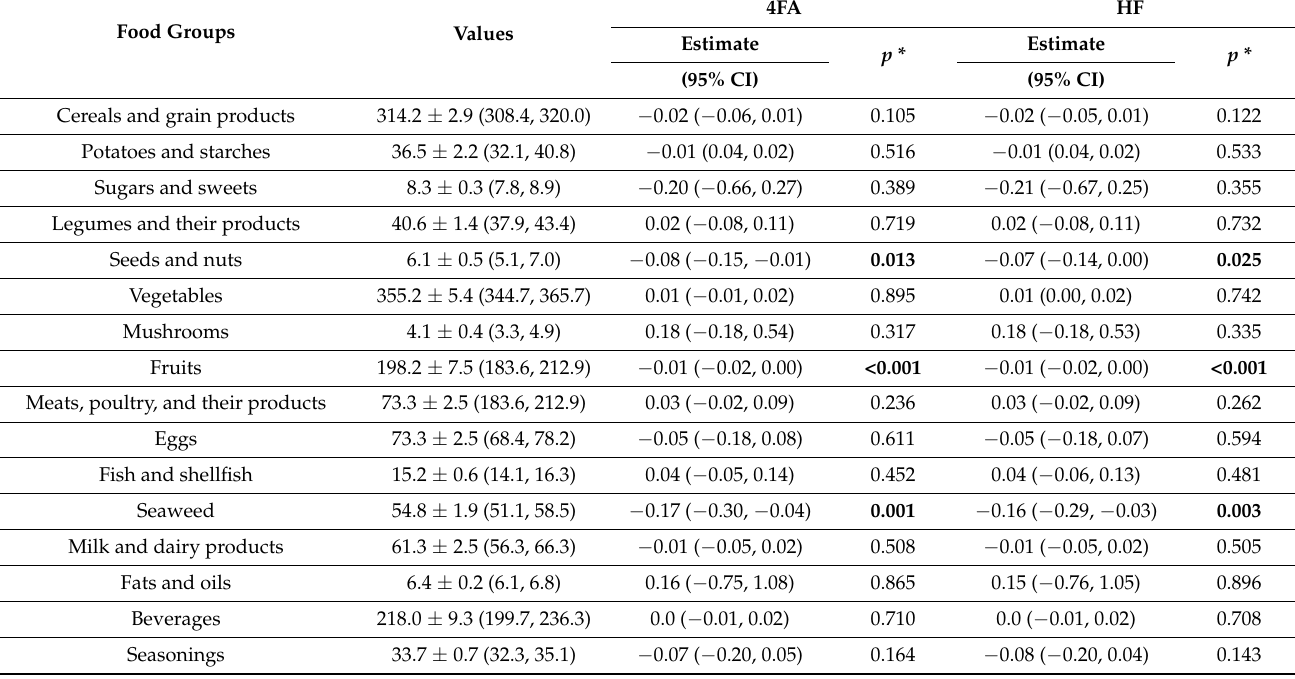
Table 2. Association between food consumption and hearing thresholds.